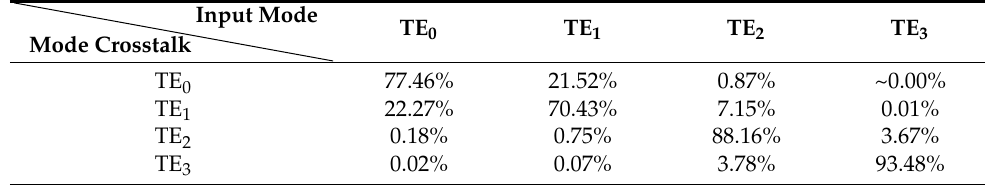
Table 1. Simulated mode crosstalk of the Euler bend.